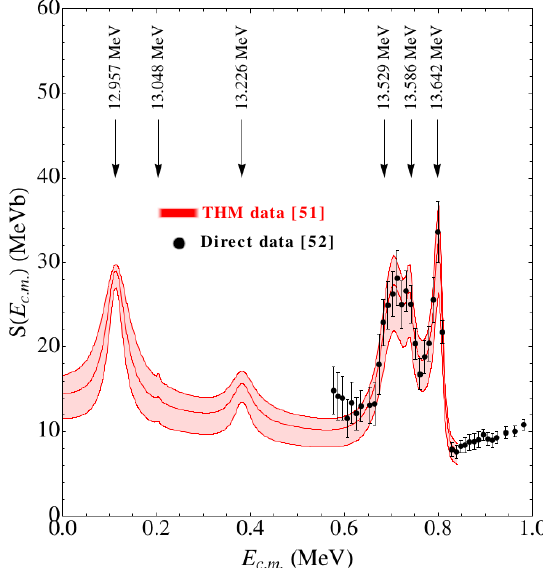
Figure 3. THM astrophysical factor of the 19 F( p ,α 0 ) 16 O reaction, normalized to the data from [52] above 600 keV, as shown in [51]. The middle red line marks the recommended S-factor, while the upper and lower red lines stand for upper and lower limits set by combined statistical, normalization and energy shift error. The solid symbols represent the direct astrophysical factor in [52]. Finally, the arrows mark the 20 Ne states contributing to the